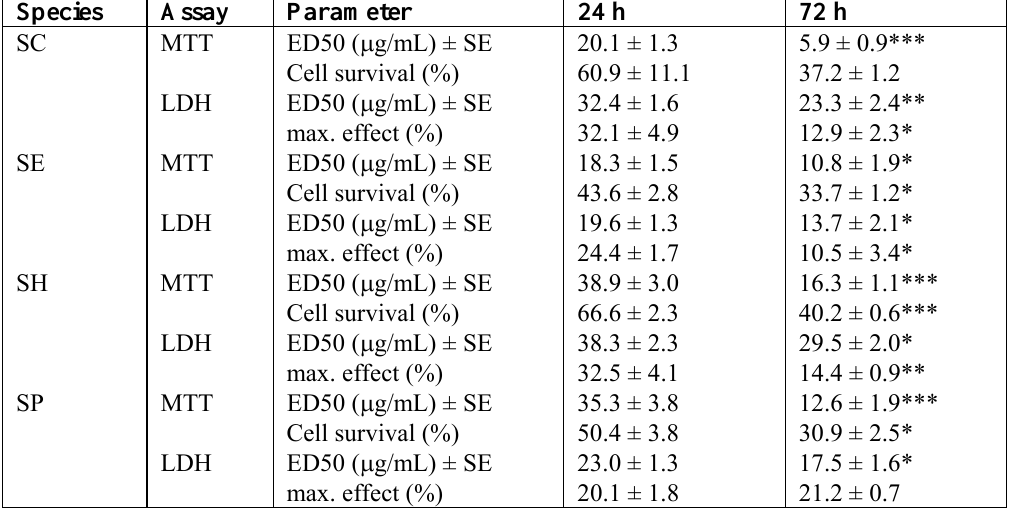
and maximal effects for MTT and LDH toxicity Table 1. ED 50